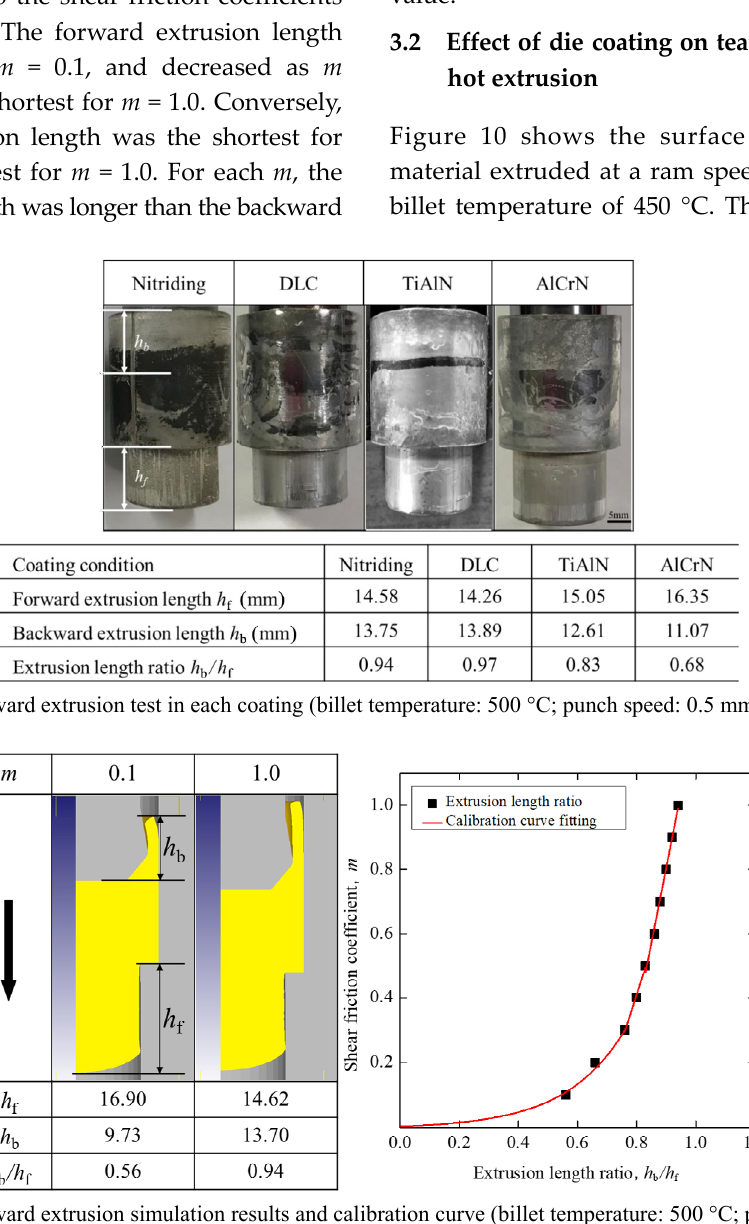
Fig. 9 Hot forward–backward extrusion simulation results and calibration curve (billet temperature: 500 °C; punch speed: 0.5